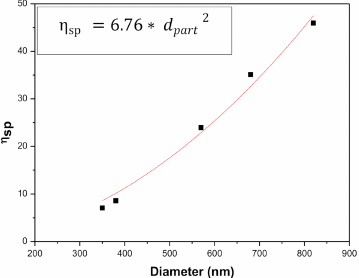
Figure 6. Correlation of the specific viscosity of EKL/PVP solutions and average diameter of resulting electrosprayed